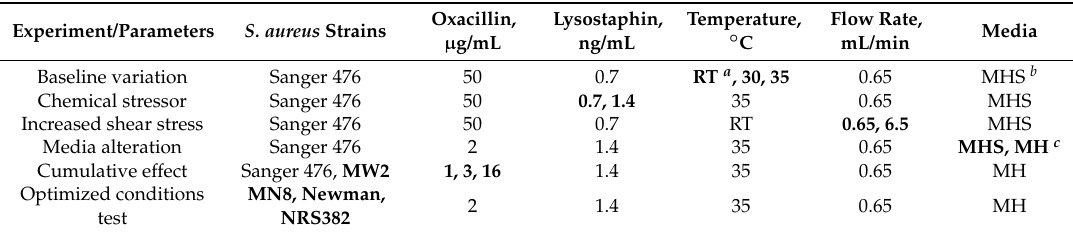
Table 1. Summary of experimental conditions (changing variable highlighted with bold